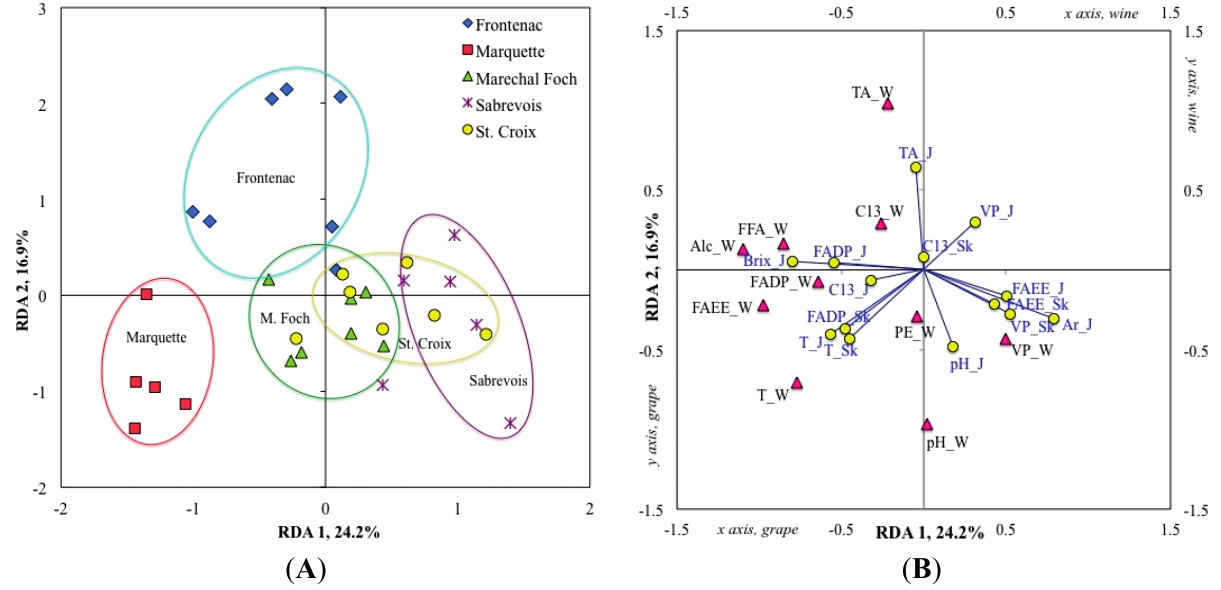
Figure 1. Redundancy analysis relating the chemical composition of the berry skin and juice (independent variables) to the chemical composition of the wines (dependant variables) made from the interspecific hybrid grape varieties Frontenac (blue diamonds), Marquette (red squares), Maréchal Foch (green triangles), Sabrevois (purple stars) and St. Croix (yellow circles). ( A ) Varieties samples plot ( n = 32); ( B ) Biplot of grape (yellow circles, 14 variables) and wine (red triangles, 10 variables). The berry skin and juice variables are identified as follow: total soluble solids (Brix_J), titratable acidity (TA_J), pH (pH_J), sum of fatty acids degradation products in juice (FADP_J) and in skin (FADP_Sk), sum of terpenes in juice (T_J) and in skin (T_Sk), sum of C 13 -norisoprenoids in juice (C13_J) and in skin (C13_Sk), fatty acid ethyl esters in juice (FAEE_J) and in skin (FAEE_Sk),